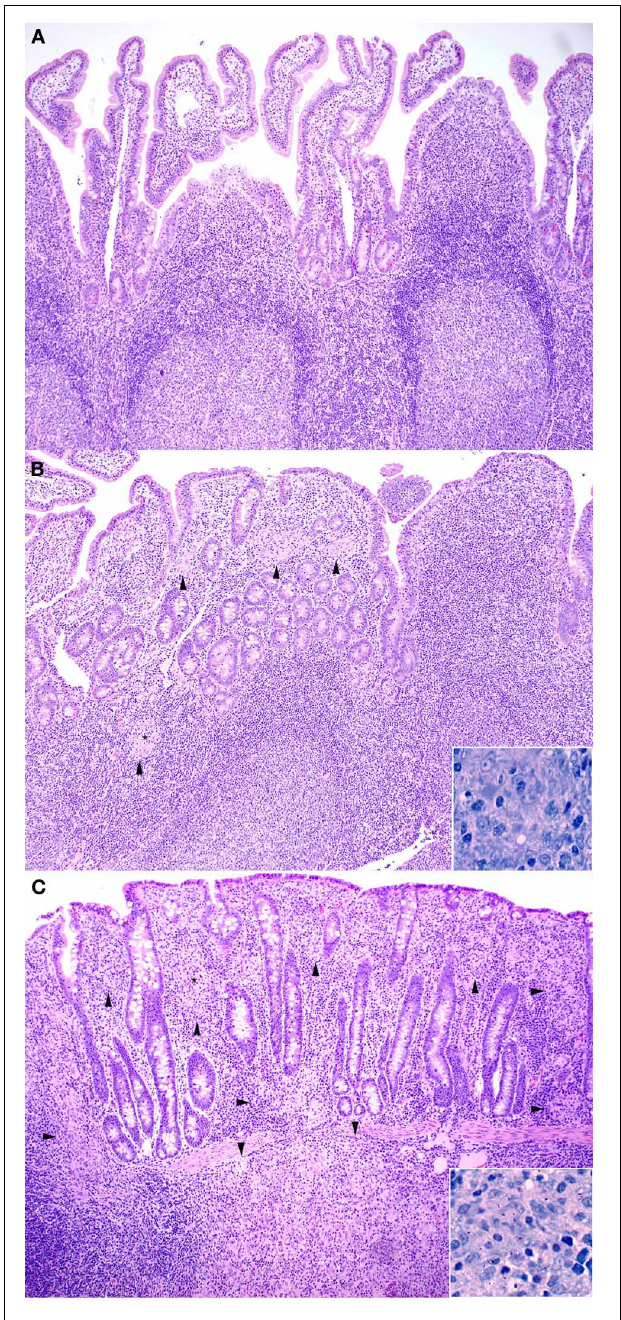
FIGURE 1 | (A–C) Note how the severity of microscopic lesions increases along with the lesion score. Arrowheads indicate foci of granulomatous inflammatory infiltrate. (A) Representative Hematoxylin and Eosin stained section of non-challenged Sham vaccinated control ileum sample (100X). Lesion score = 0. (B) Hematoxylin and Eosin stained section of Silirum® vaccinated and challenged ileum sample (100X). Inset shows Kinouyan’s acid-fast stain with a single acid-fast bacillus in center from area labeled with a small star (600X). Lesion score = 3.54. (C) Hematoxylin and Eosin stained section of higher lesion score in a 319 vaccine (group 5) ileum sample (100X). Inset shows Kinouyan’s acid-fast stain with multiple acid-fast bacilli from area labeled by a small star (600X). Lesion score = 10.42.